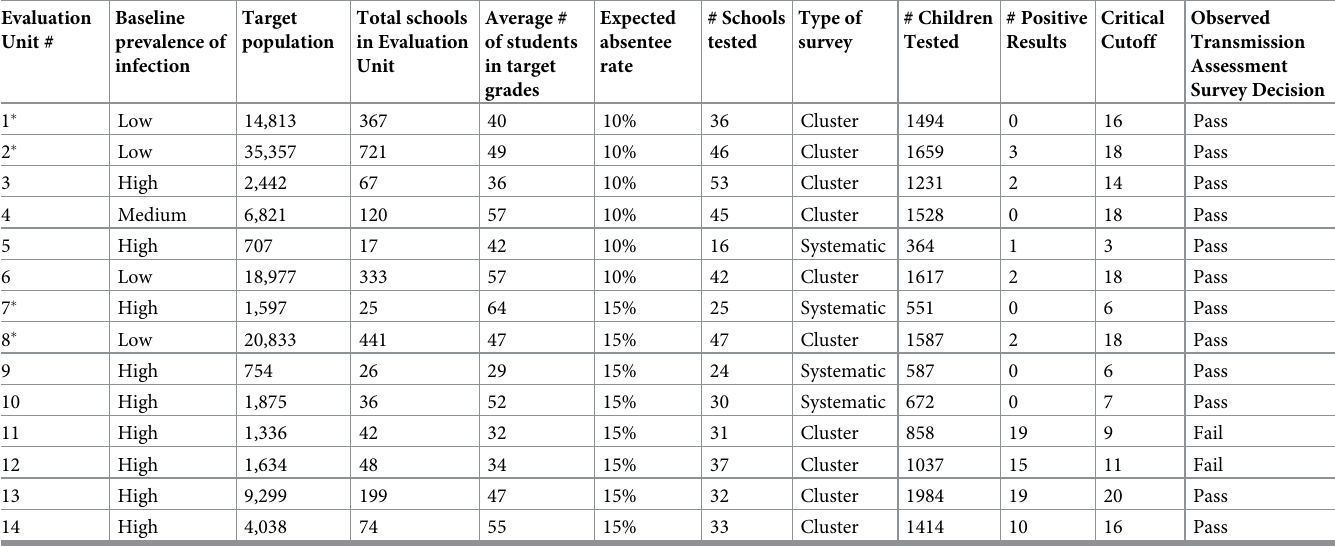
Table 1. Characteristics of individual Evaluation Units and Transmission Assessment Survey results. Evaluation Baseline Unit # prevalence